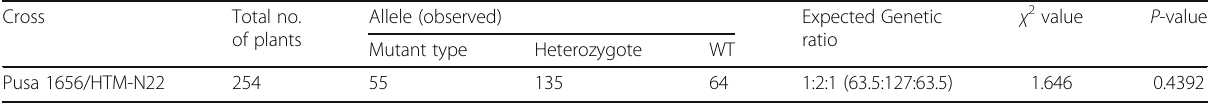
Table 3 Genotypic segregation of F 2 population from the cross, Pusa1656/HTM-N22 for RM6844 marker Cross Total no. Allele of plants